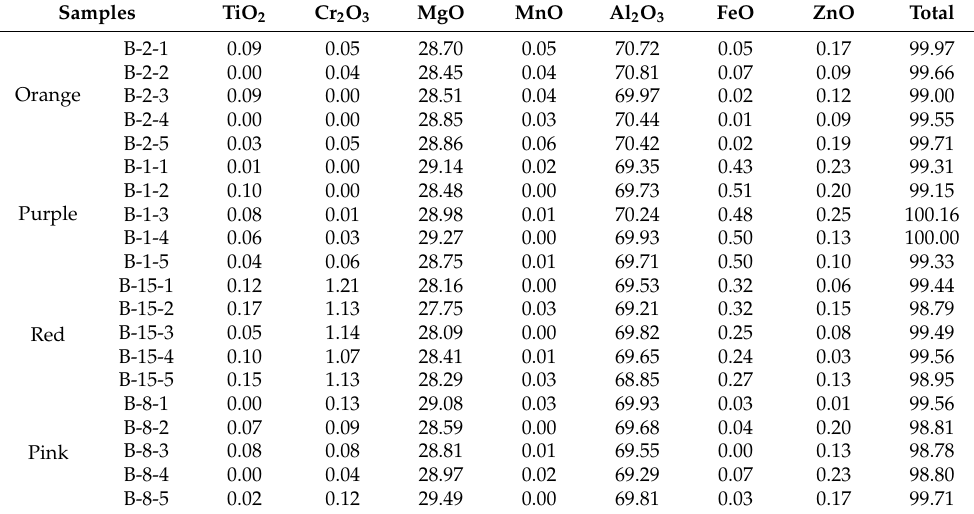
Table 2. Major element composition (wt.%) of spinel samples from Mogok by EPMA.